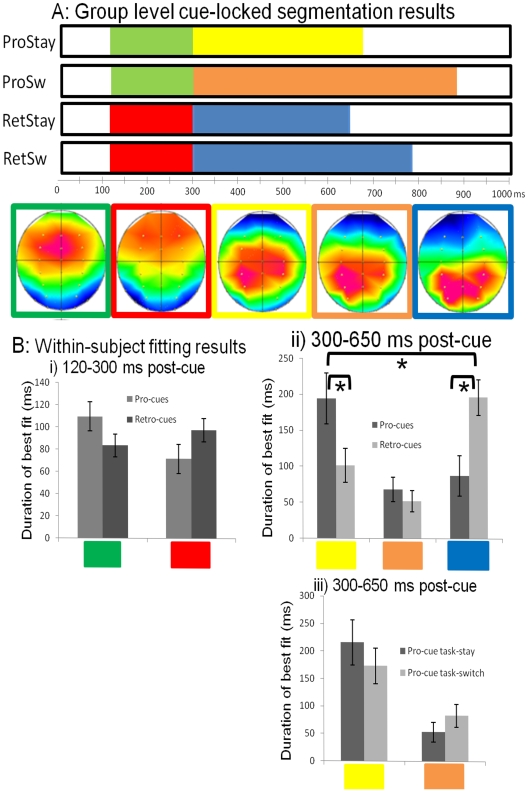
Topographical analyses.A) The result of the group-level segmentation process. The different colors show the durations of the various clusters of topography, across the four conditions, for the cue-locked epoch. Each of these clusters can be summarised as a single topography – the mathematical average of all topographies within that cluster – shown below. B) The results of the within-subject fitting procedure: i) the mean duration for which the ‘red’ and ‘green’ topographies were the best fit across pro-cue and retro-cue trials, between 120 and 300 ms; ii) the mean duration for which the ‘yellow’, ‘orange’ and ‘blue’ maps were the best fit across pro-cue and retro-cue trials, between 300 and 650 ms; and iii) the mean duration for which the ‘yellow’ and ‘orange’ maps were the best fit between 300 and 650 ms. In all cases the error bars show the standard error of the mean. In all cases the ‘*’ denotes significant differences, the absence of this denotes non-significant differences.